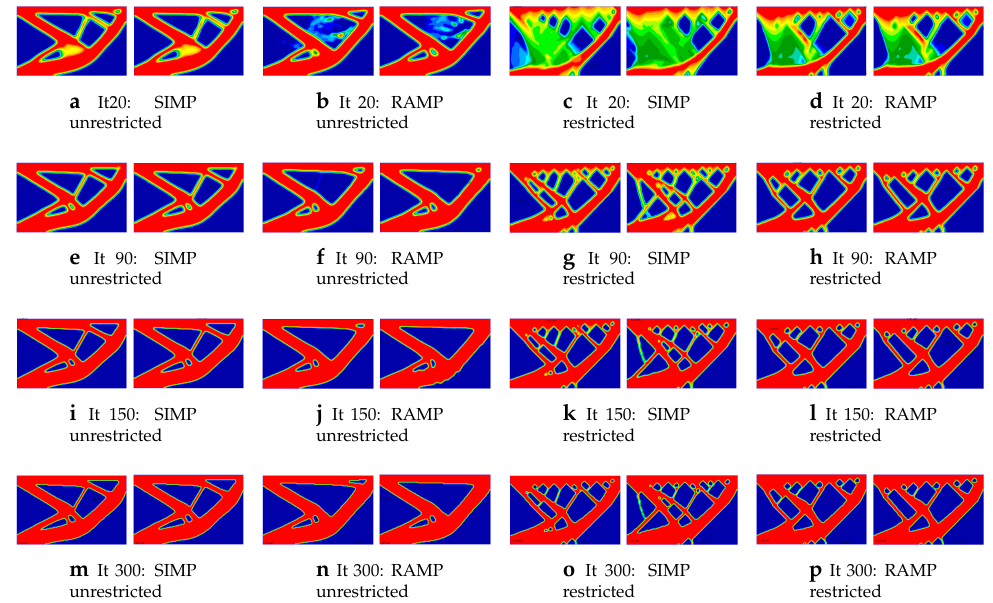
Figure 4. Topology optimization of the cantilever problem at Iterations 20, 90, 150, and 300. In each subfigure, the left image uses the full precision structural equilibrium, and the right image uses approximate structural equilibrium. SIMP, Solid Isotropic Material with Penalization; RAMP, Rational Approximation of Material